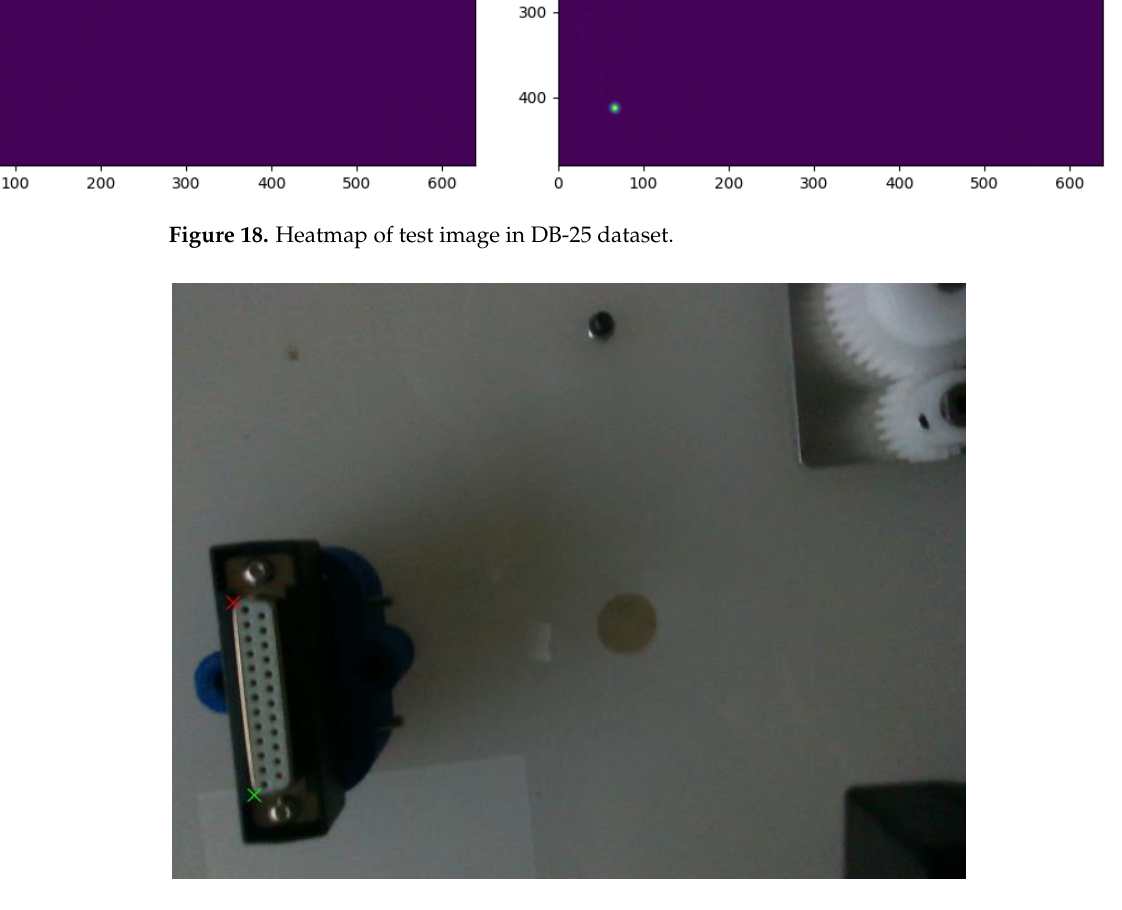
Figure 19. Workpiece landmark detection.